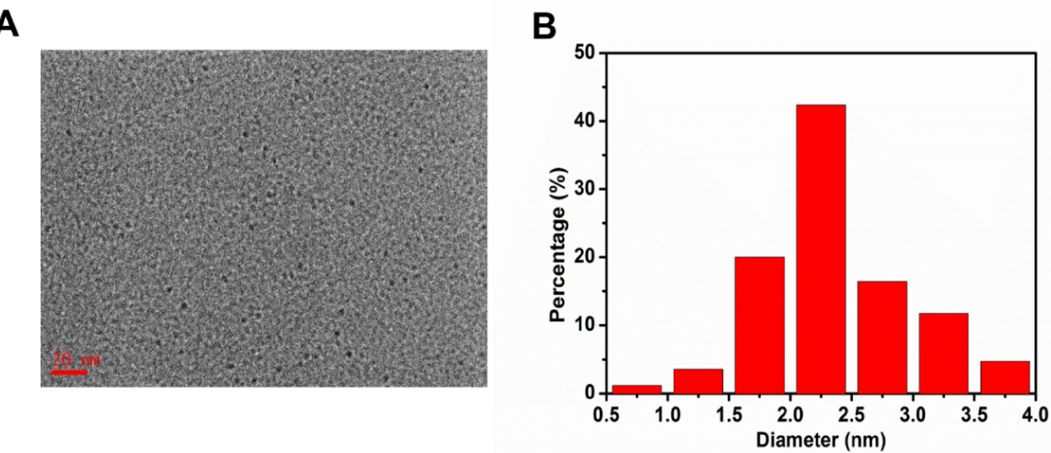
Figure 1. ( A ) TEM image of N–CDs, the scale bar is 20 nm. ( B ) The corresponding size–distribution histogram.